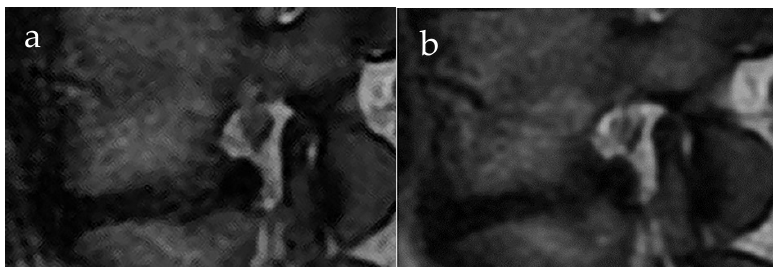
Figure 3. MRI of a left L4–L5 foramina acquired without loading of the spine ( a ) and with loading ( b ). A change in the foraminal shape and increase in disc bulging can be observed; the nerve root is surrounded by fat in both MR images. Table 1. Distribution of foraminal area change at MRI during loading compared to unloaded. Area Change with Loading